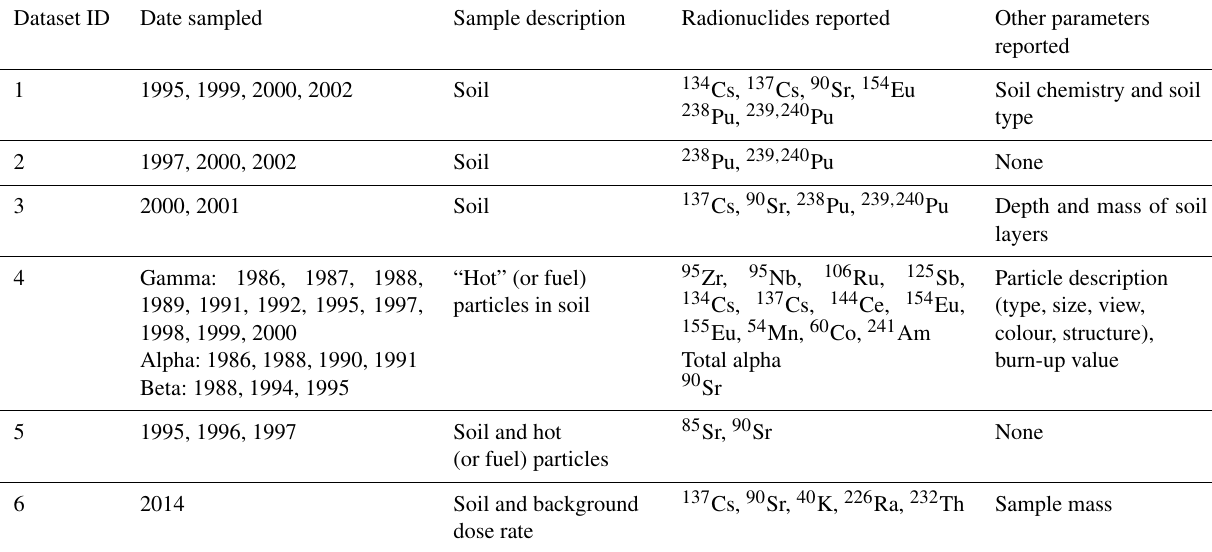
Table 1. A description of the data presented in this paper and available from Kashparov et al., 2017. Dataset